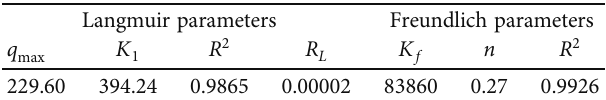
Figure 7: Adsorption isotherm model of MB by ZLCH-b. (a) Langmuir isotherm. (b) Freundlich isotherm. Table 4: Langmuir and Freundlich ’ s isotherm models of MB adsorption onto